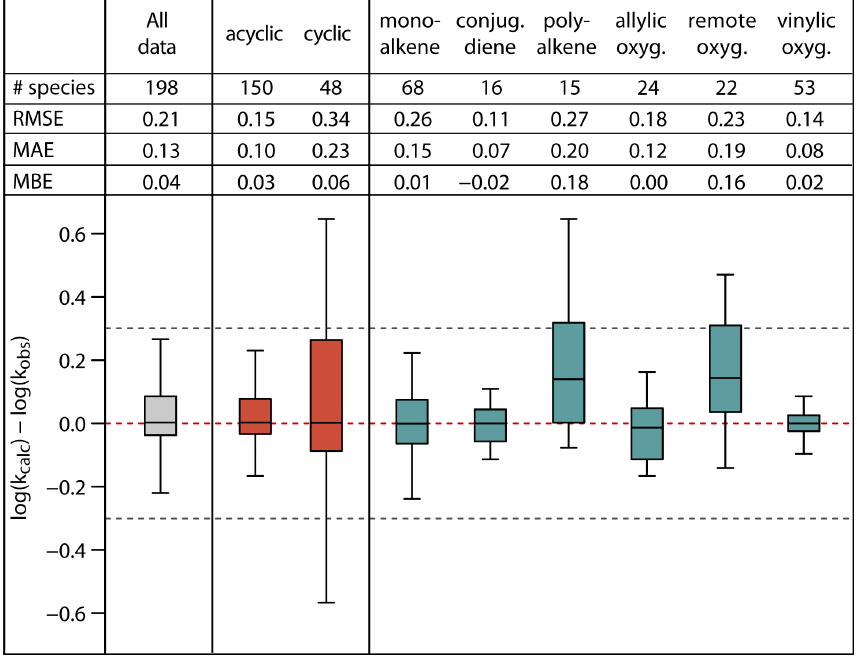
Figure 7. Root-mean-square error (RMSE), mean absolute error (MAE), mean bias error (MBE) and box plot for the error distribution in the estimated log k 298K values for the full set and subsets of the unsaturated species in the database. The bottom and the top of the boxes are the 25th (Q1) and 75th percentiles (Q3); the black band is the median value. The whiskers extend to the most extreme data point, which is no more than 1 . 5 × (Q3–Q1) from the box. The black dotted lines correspond to agreement within a factor